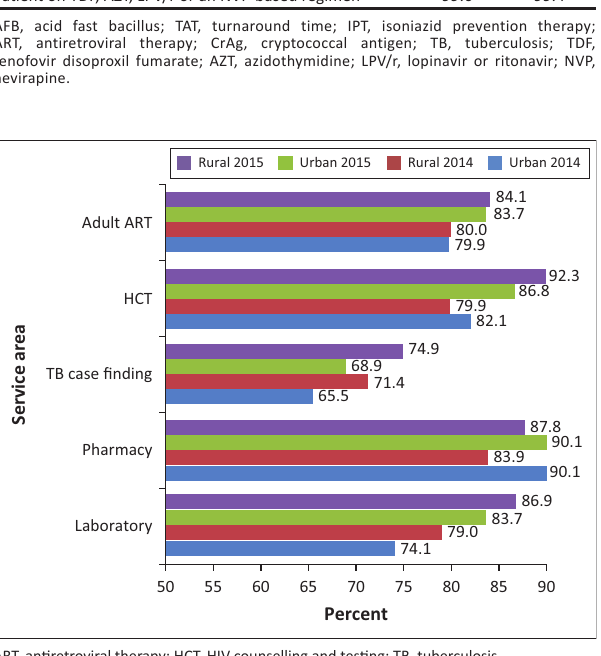
FIGURE 2: Urban and rural quality audit scores in 2014 and 2015 (pre- and post- continuous quality improvement